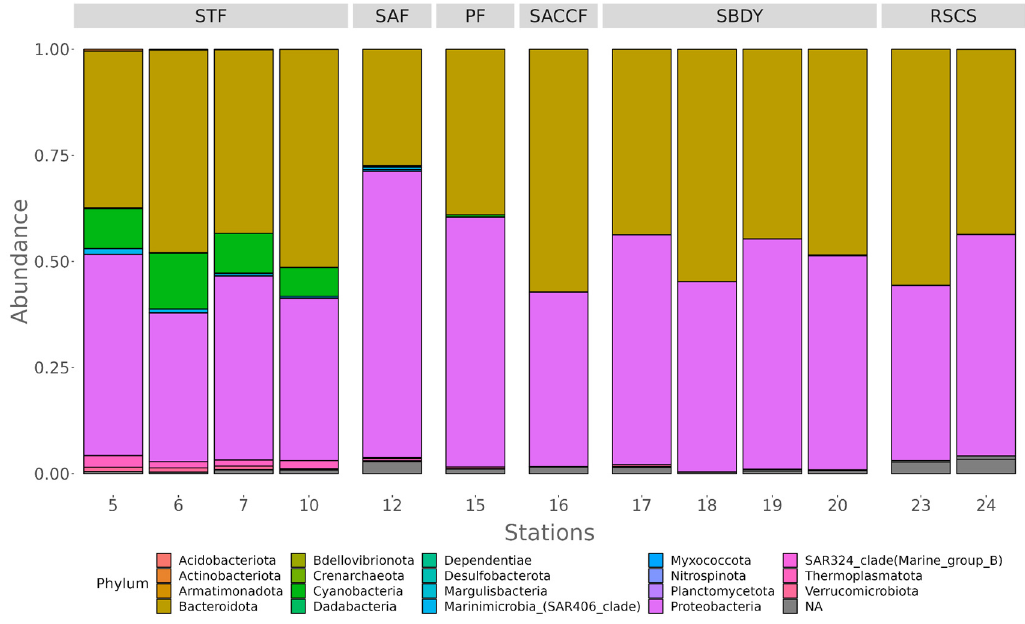
Figure 2. Diversity at the phylum level for all the stations considered. On top of the figure are the fronts to which each sampling station can be assigned. STF—South Tropical Front; SAF—Sub- Antarctic Front; PF—Polar Front; SACCF—Southern ACC Front; SBDY—Southern Boundary Front; RSCS—Ross Sea Continental Shelf.